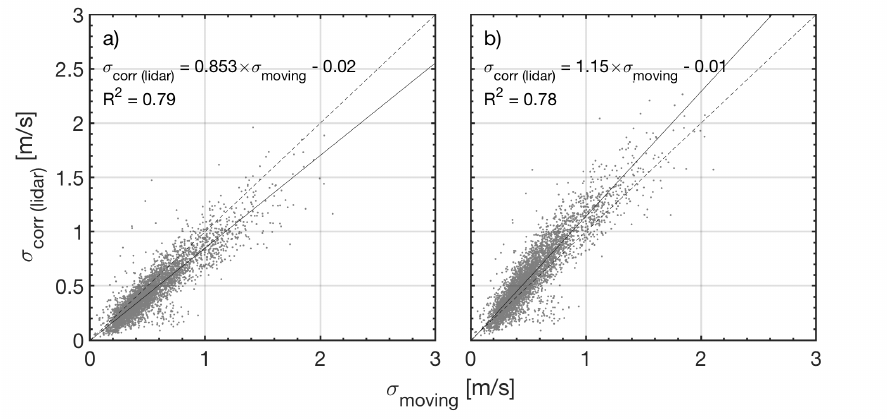
Figure 7. Comparison between 10-min floating-lidar HWS standard deviation measurements and motion-corrected ones by using Equation (16) versus Equation (17). ( a ) uncorrelation hypothesis (Equation (16)); ( b ) linear-correlation hypothesis (Equation (17)). The dashed line indicates the 1:1 line and the solid line shows the linear